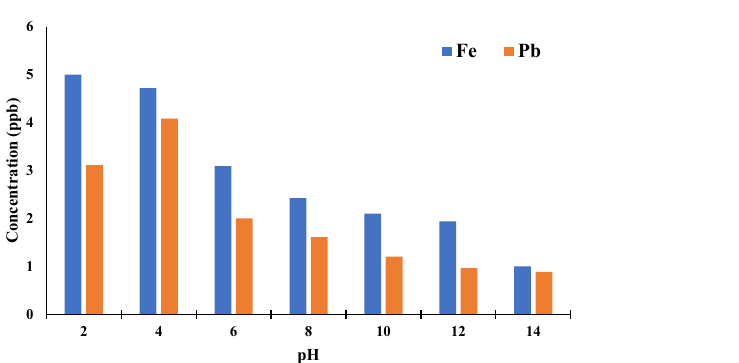
Figure 4. Concentration of lead and iron in the leach liquor solution at different pH values (pH = 2–14, T = 25